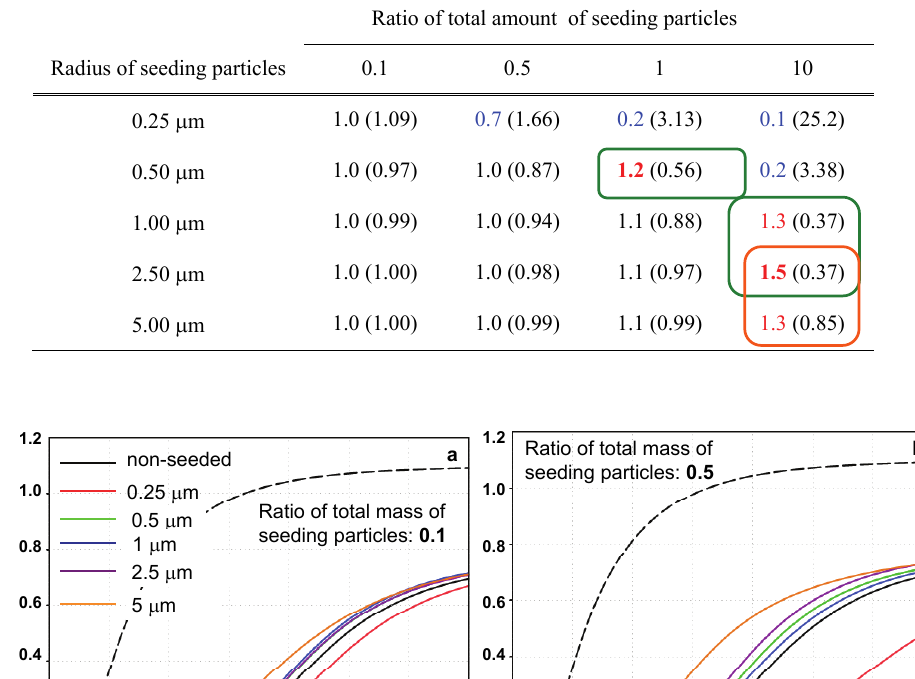
Table 2. Ratios of seeded-case to non-seeded-case accumulated surface rainfall averaged over the domain at 60 min. Seeding of shallow convective cloud is carried out with monodisperse salt particles of different sizes and total masses. Ratios in blue and red indicate a significant decrease and increase, respectively. Ratios of seeded-case to non-seeded case (665 cm -3 ) cloud droplet number concentrations at 50 m above the base of the cloud center at 11.5 min are shown in parentheses.